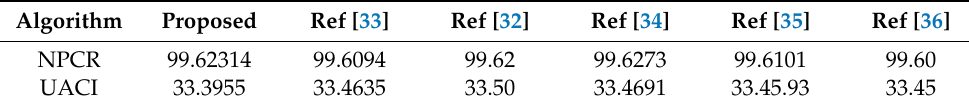
Table 3. The proposed method with other encryption methods.